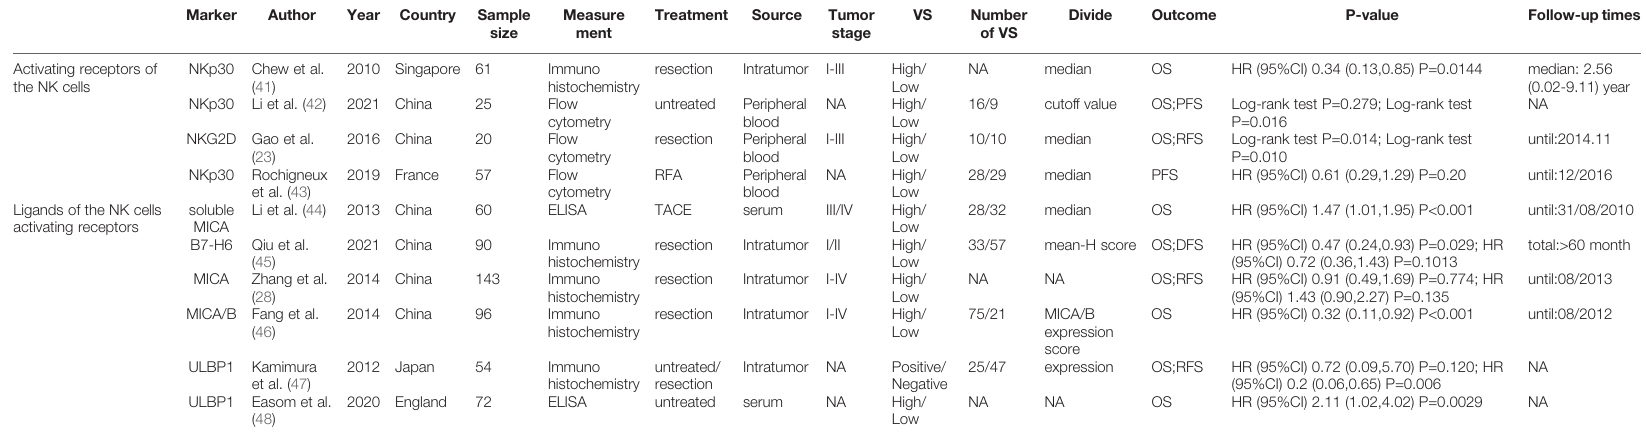
NK, Natural killer; CI, Con fi dence interval; HR, Hazard ratio; RFA, Radiofrequency ablation; ELISA, Enzyme-linked immunosorbent assay; TACE, Transcatheter arterial chemoembolization; OS, Overall survival; DFS, Disease-free survival; RFS, Recurrence-free survival; PFS, Progression-free survival; NA, Notavailable.